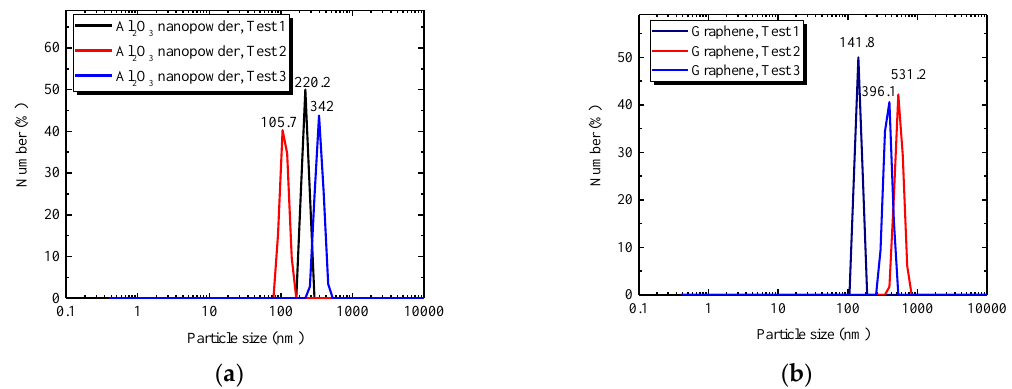
Figure 7. Sizes for different nanoparticles with DLS device. ( a ) Al 2 O 3 nanopowder nanofluid; ( b ) graphene nanofluid.